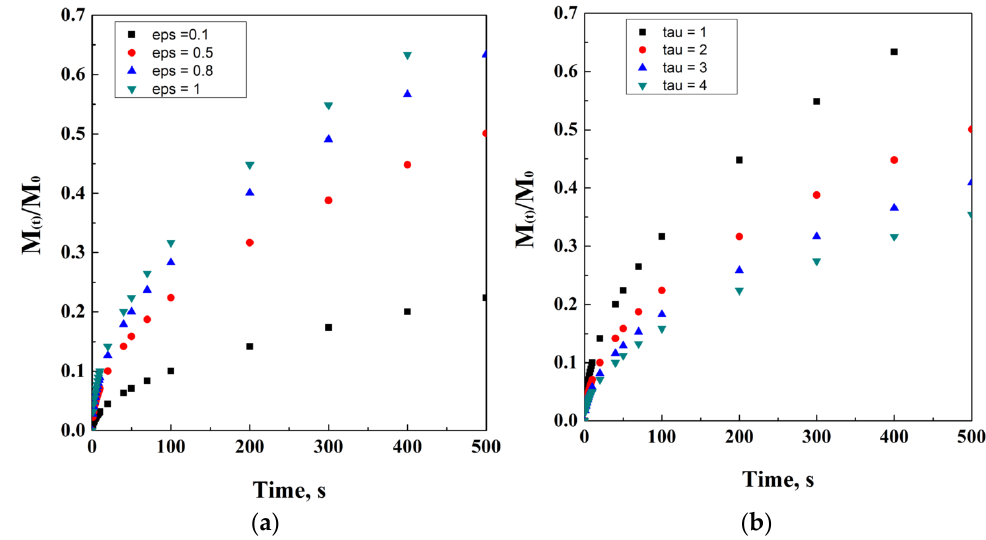
Figure 4. Higuchi’s model at different porosity ( a ) and tortuosity ( b )